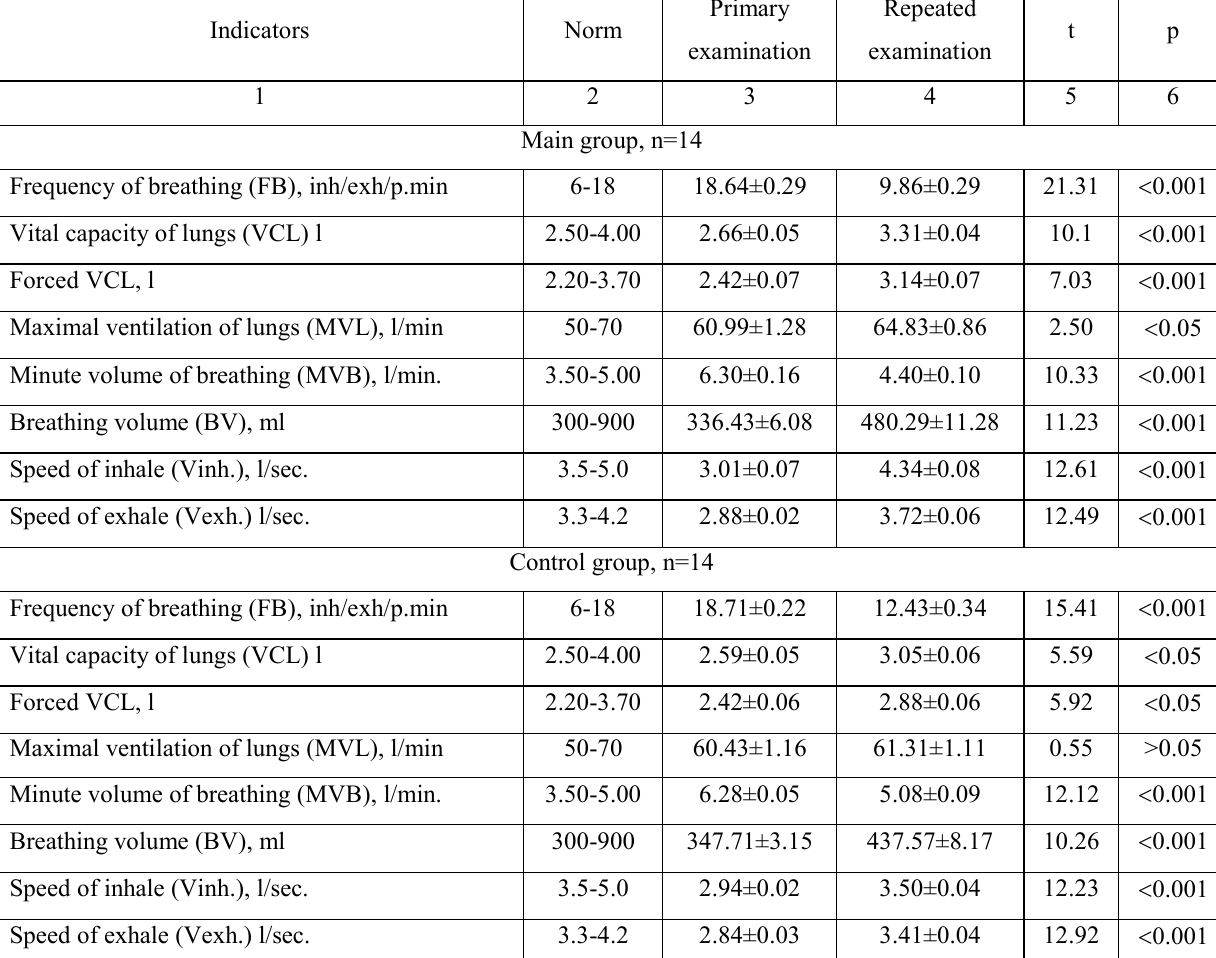
Spirographyc indicators of main and control groups’ patients received at repeated examination (М  m) Indicators Norm